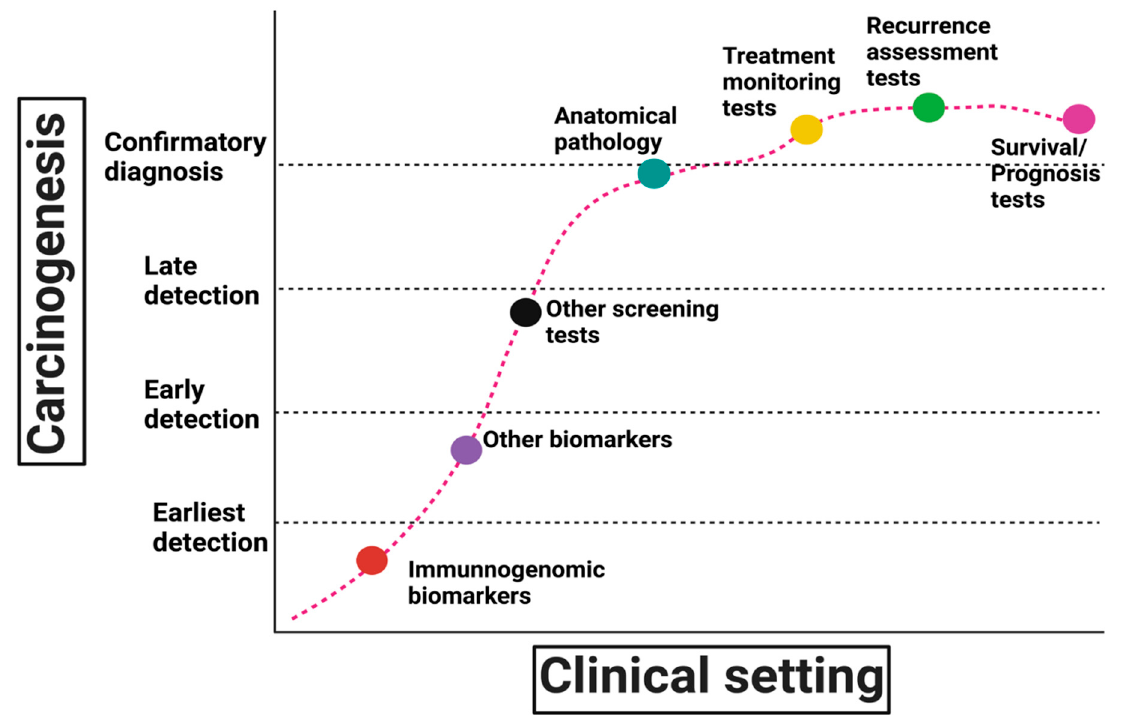
Figure 2. Clinical applications of immunogenomic biomarkers in carcinogenesis. In LS, im- munogenomic biomarkers could be more sensitive for detecting malignancies than conventional imaging or other approaches. This sensitivity can be exploited in several ways, such as detecting cancers in LSVH before symptoms or radiological manifestations appear and detecting minimal residual disease. As an alternative to invasive surveillance and cancer screening, immunogenomic biomarkers can be used to screen for cancer even in the absence of other clinical evidence. They curative therapies. In patients with radiographically detectable disease, immunogenomic biomarkers may also be more sensitive for tailored monitoring of tumour response (treatment monitoring